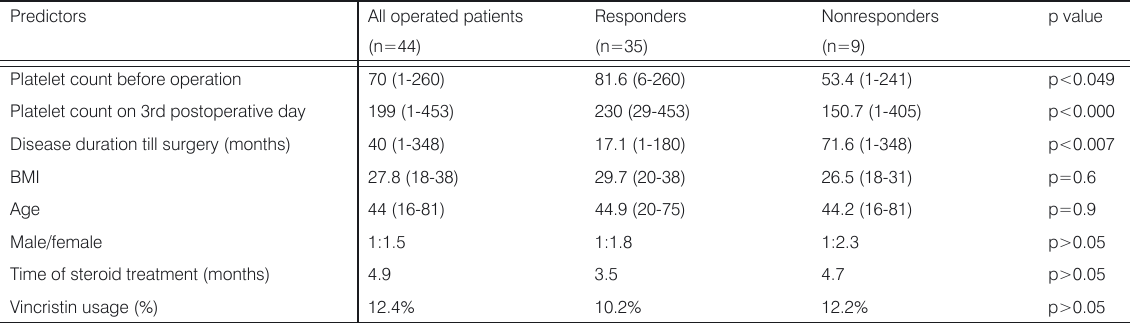
Table 3. Patient characteristics related to long-term response to splenectomy (Results of univariate analysis).